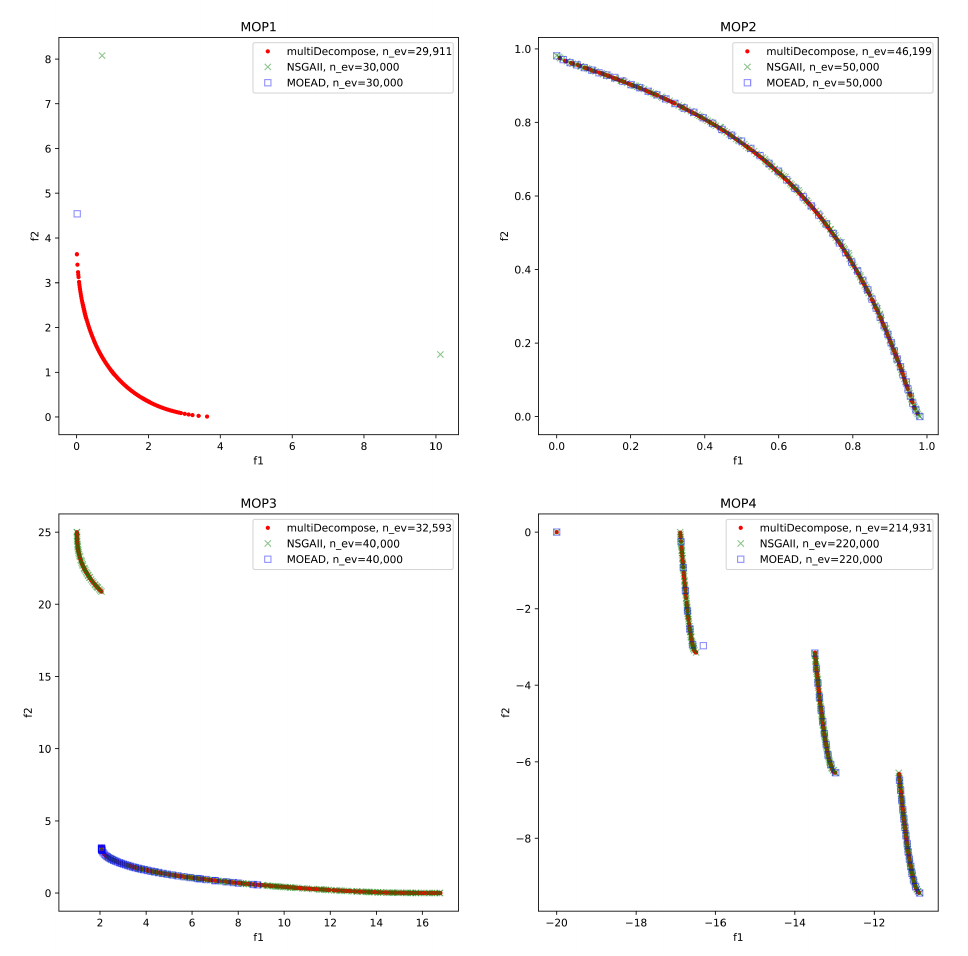
Figure 4. PFs of multiDecompose, NSGA-II and MOEA/D on all MOP instances where n _ ev denotes the number of the function